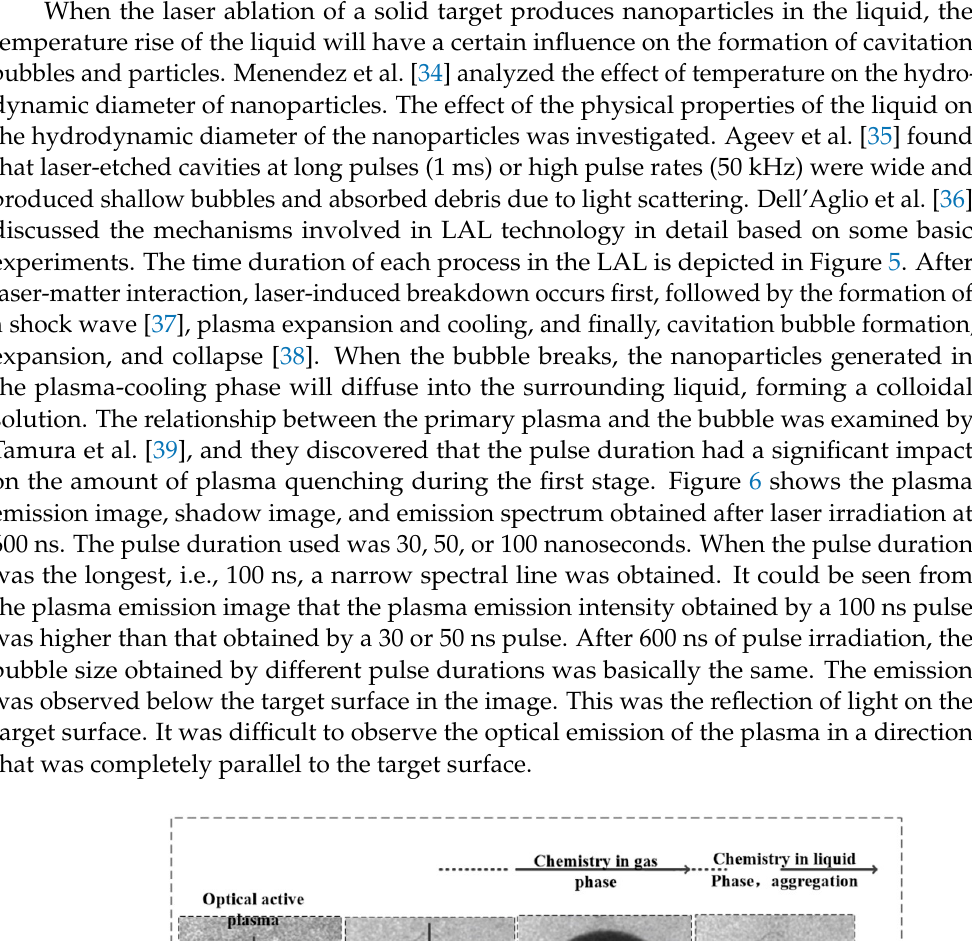
Figure 6. Plasma emission images after laser irradiation for 600 ns (pulse durations were 30 ns, 50 ns, and 100 ns, respectively). Reprinted/adapted with permission from Ref. [39]. Copyright 2015,